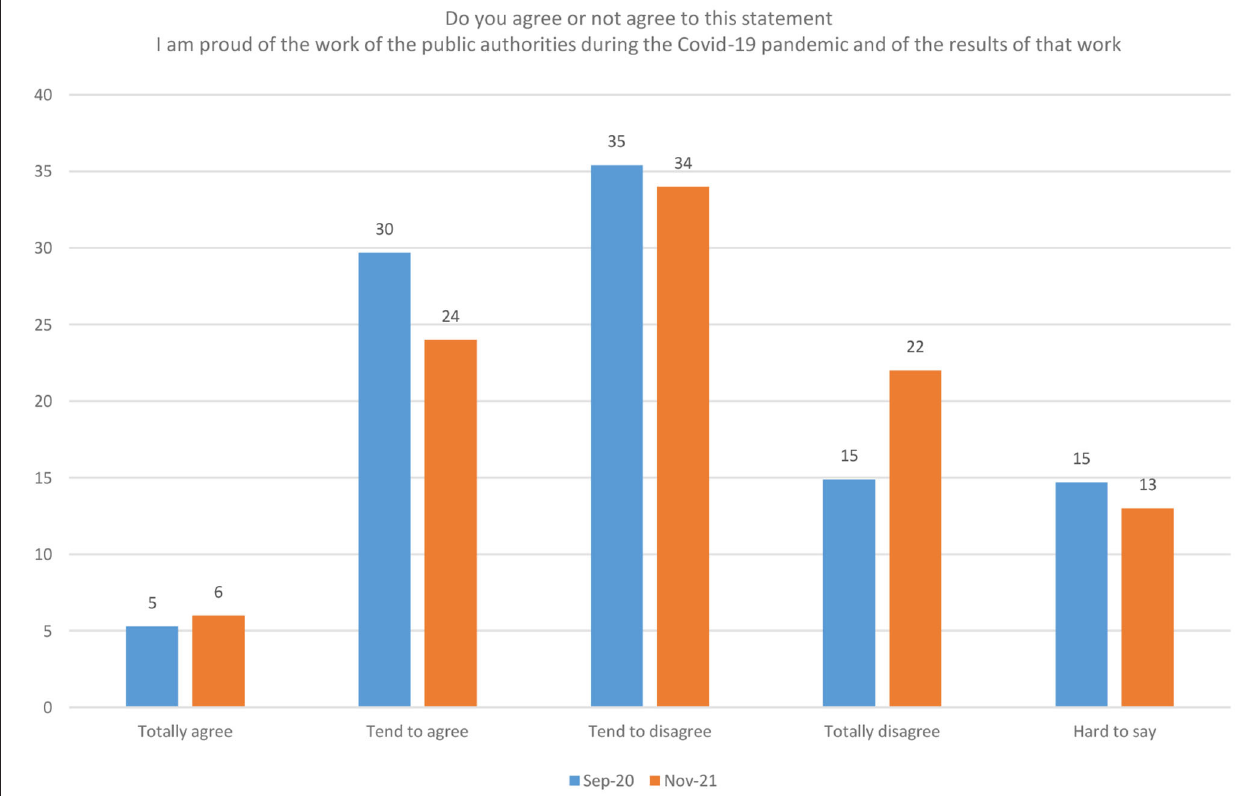
FIGURE 4 | Public satisfaction with the work of public authorities during the pandemic, percent of respondents, 2020-2021 (10). Source: public poll carried out in the framework of this study.